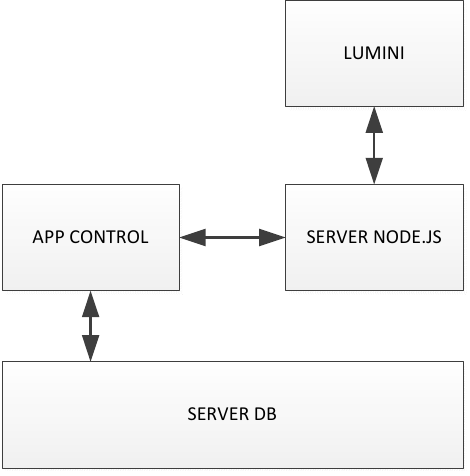
Figure 4. Block diagram of the Lumini C acquisition system via Android app.